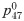
The original projection vector p470, the reprojection vector, p471, and the corrected projection vector, p473, for the head phantom of size 128 × 128 and θ = 47°.(a) The whole vector, (b) the portion of the black in (a).